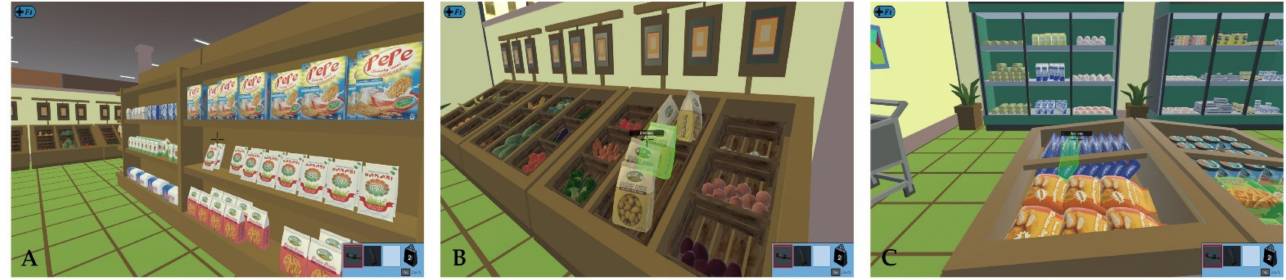
Figure 3. Sample pictures presenting the participant’s first-person view while collecting items on the Virtual Supermarket Shopping Task (VSST) [129]. The names of the products are visible when pointed at. Reprinted with permission from [129]. Copyright 2021 Czech Academy of Sciences. Participant‘s first person view: ( A ) while collecting an item from the shelf, ( B ) while collecting fruits and vegetables, and ( C ) while collecting products from the